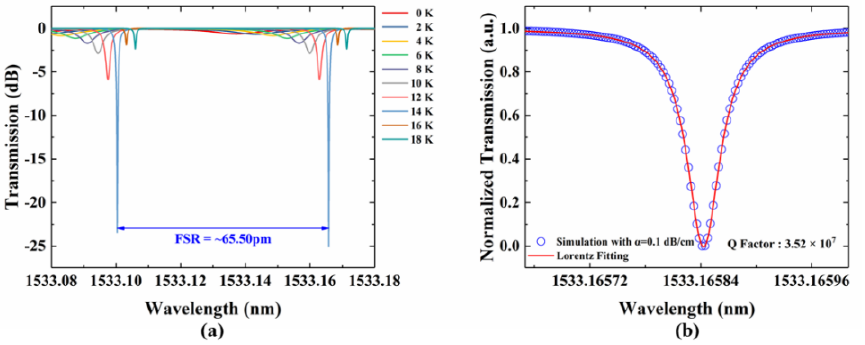
Figure 2. ( a ) Calculated normalized transmission with coupling-condition tuning of tunable MRR; ( b ) calculated deepest resonant peak with Lorentzian fitting.